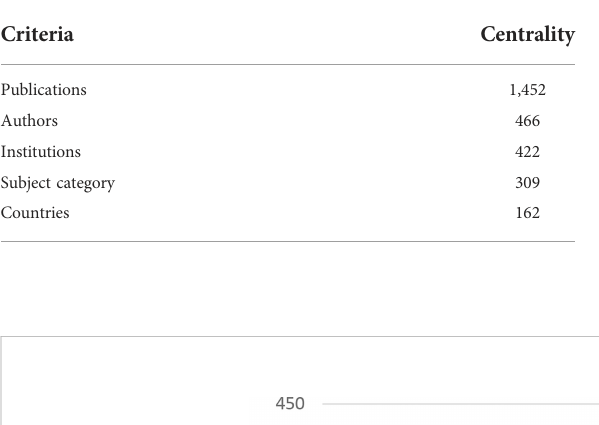
TABLE 2 Descriptive statistics of the database in this study.